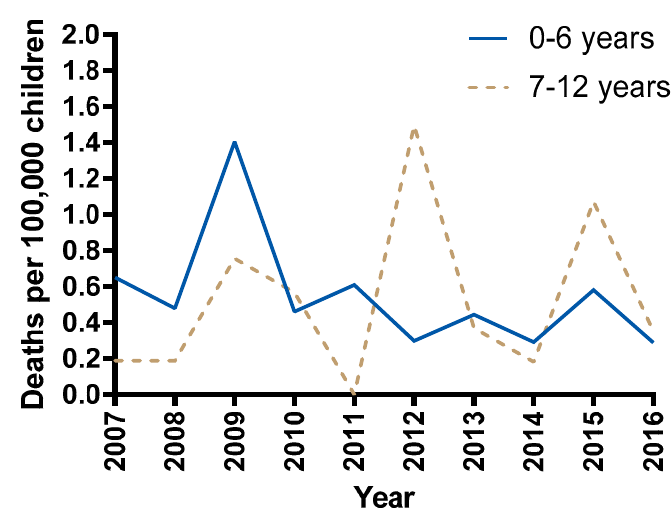
Figure 6. Rate of child passenger deaths in NSW 2007–2016 by age group.